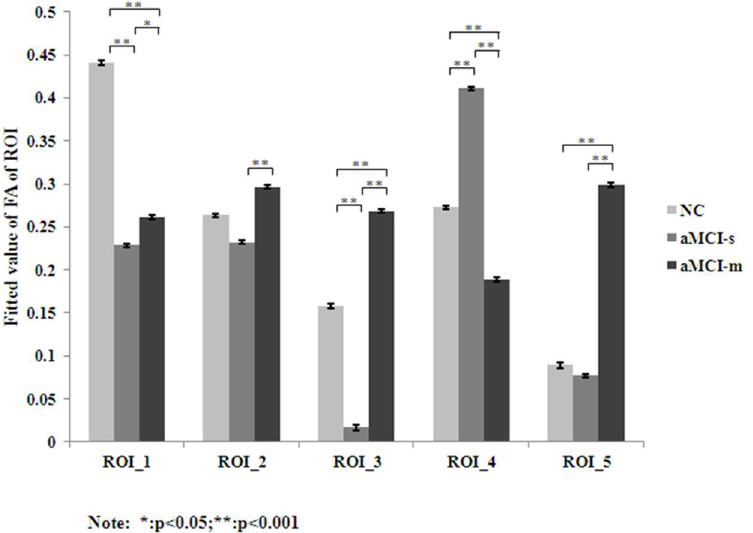
Fig 2. Paired-wise comparison of FA values in different ROIs. ROI were definedbasedon the activated clusters of ANCOVA (Table 1). * represents p < 0.05; ** represents p <